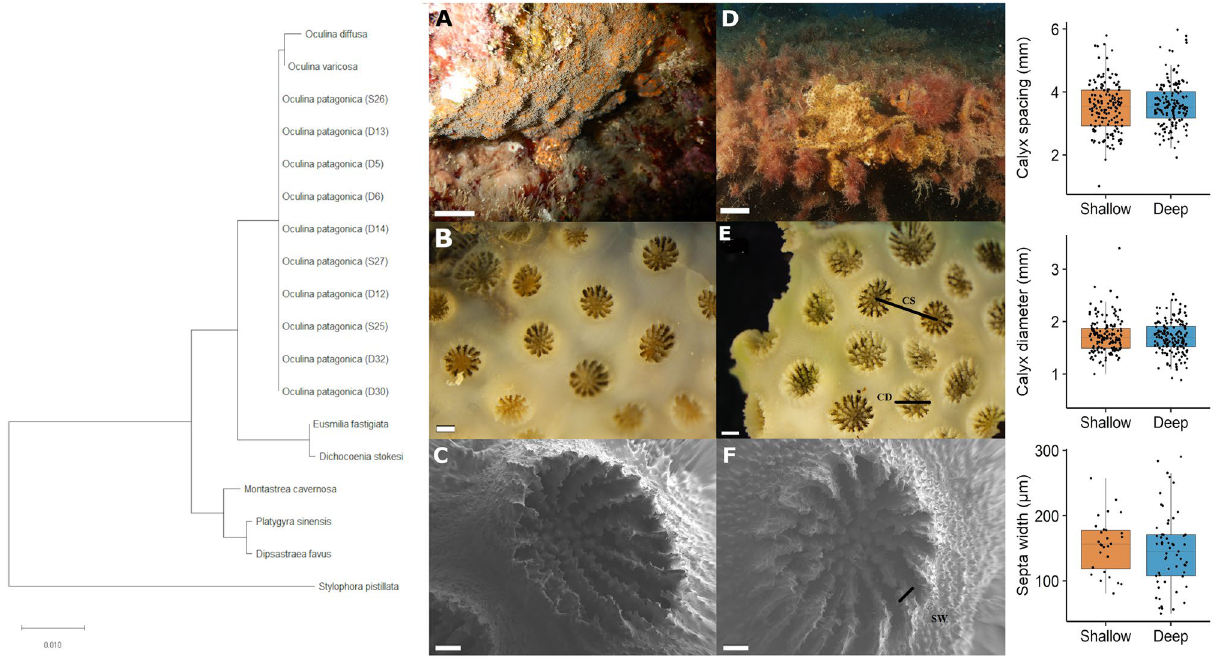
Figure 3. Verification of species identity of all colonies collected as Oculina patagonica , using both genomic (CO1 gene sequencing) and morphological features. The evolutionary history was inferred using the Neighbour- Joining method and evolutionary distances were computed using the Maximum Composite Likelihood method (units: number of base substitutions per site) using the software MEGA X. Images ( A – C ) are of shallow colonies and ( D – F ) deep colonies. CS Calyx spacing, CD Calyx diameter, SW Septa width. Scales bar lengths are 1 cm ( A , D , in situ), 1 mm ( B , E , binocular microscopy), and 100 μM ( C , F , scanning electron microscopy, mag. × 60). Graphs in the right panel display measured skeletal features on O. patagonica from 30 m (’Deep’, blue boxes) and 2 m (’Shallow’, red boxes) water depth. Horizontal black lines within boxes are median values and box limits represent 1st and 3rd quartiles. Whiskers represent 1.5 times the interquartile range. Round black points are individual sample data. No statistically significant differences were present between deep and shallow corals (Student’s t-test, p ≥